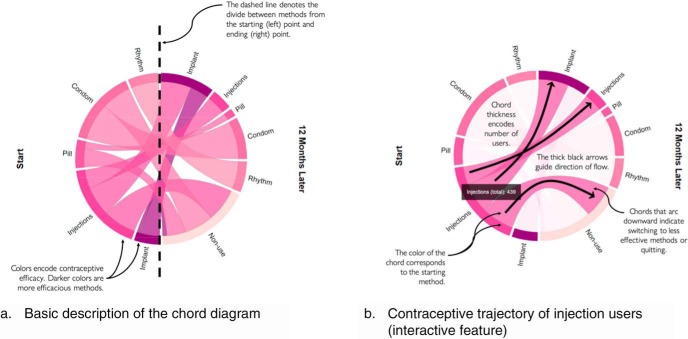
How to Read a Chord Diagram Showing Contraceptive UseThis figure displays a chord diagram using hypothetical data on contraceptive use at 2 time points: baseline (start) and follow-up (12 months later). The dashed line (Panel a) splits the chord diagram between the 2 time points. The interactive feature of the same chord diagram (Panel b) is shown, with a focus on women reporting injection use at baseline. Arrows and dotted lines are added for demonstration purposes and are not present in the actual chord diagrams.